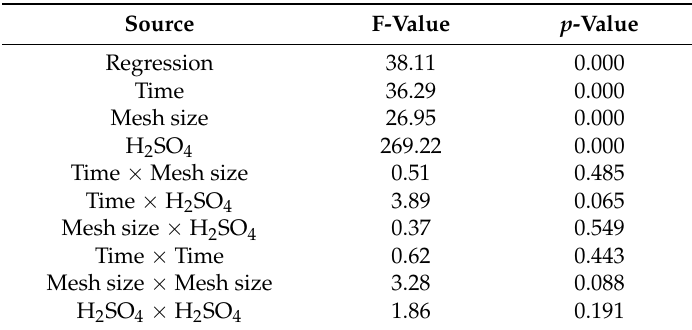
Table 6. ANOVA Mn